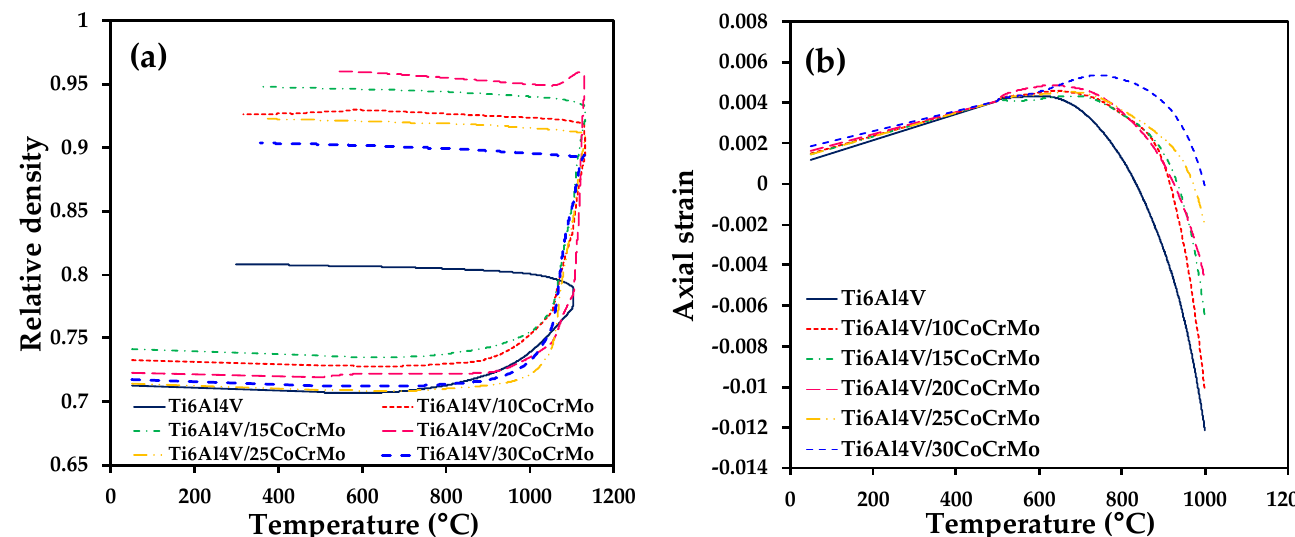
Figure 6. ( a ) Evolution of the relative density during the sintering cycle and ( b ) axial strain of samples versus temperature.